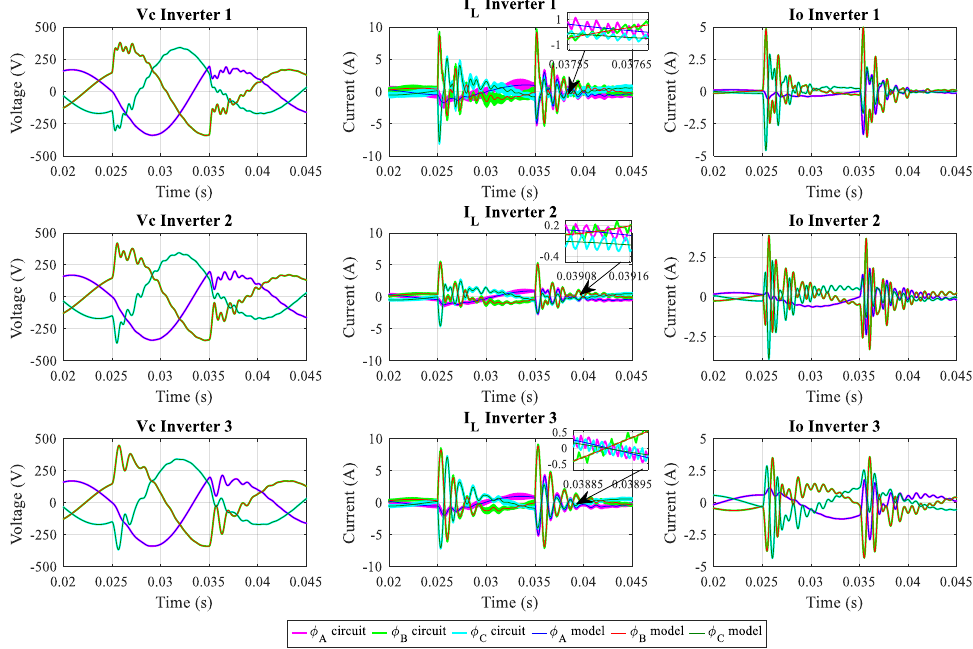
Figure 13. State-vector waveforms for the mathematical model and the circuit in islanded mode in the ABC frame.